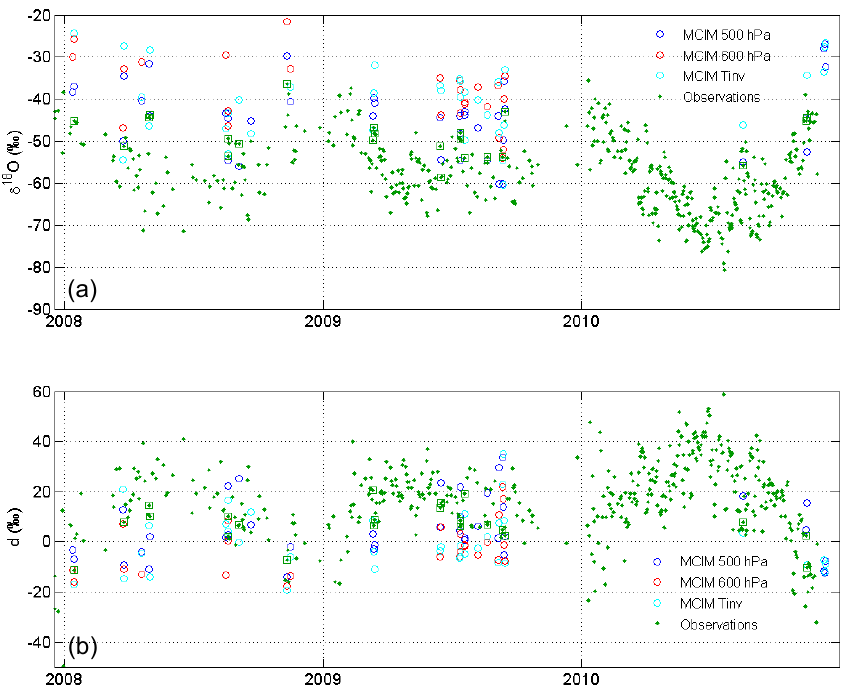
Figure 9. Observed and modeled (a) δ 18 O and (b) deuterium excess for days with moisture source estimates with Dome C temperature taken at 500hPa level, 600hPa level, and at the upper limit of the temperature inversion layer (derived from radiosondes as described in the text). The green squares mark cases for which trajectory calculations were carried out.